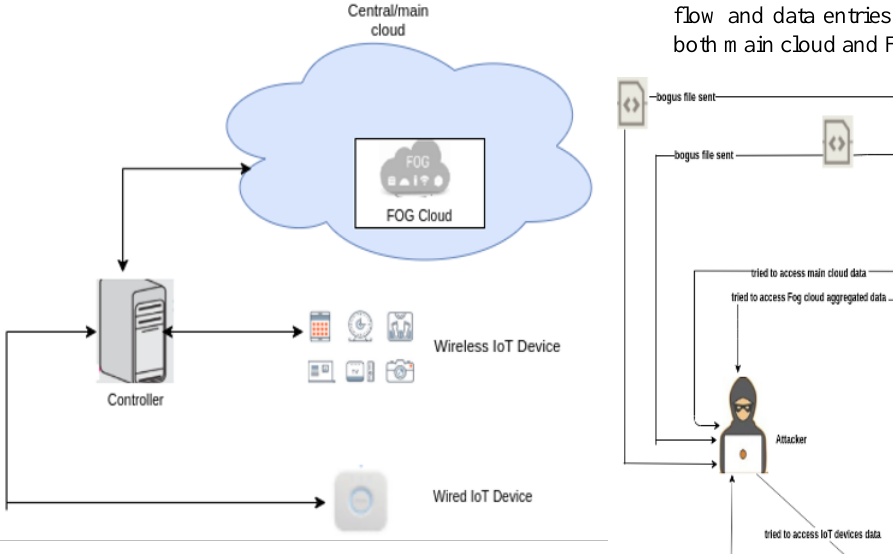
Figure 3. IoT-Cloud Integrated model